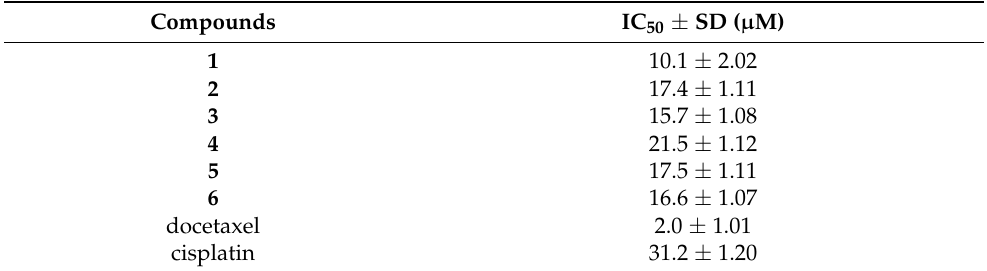
Table 1. Cytotoxic activity of compounds 1 – 6 against PC3 prostate cancer cells (MTT assay).